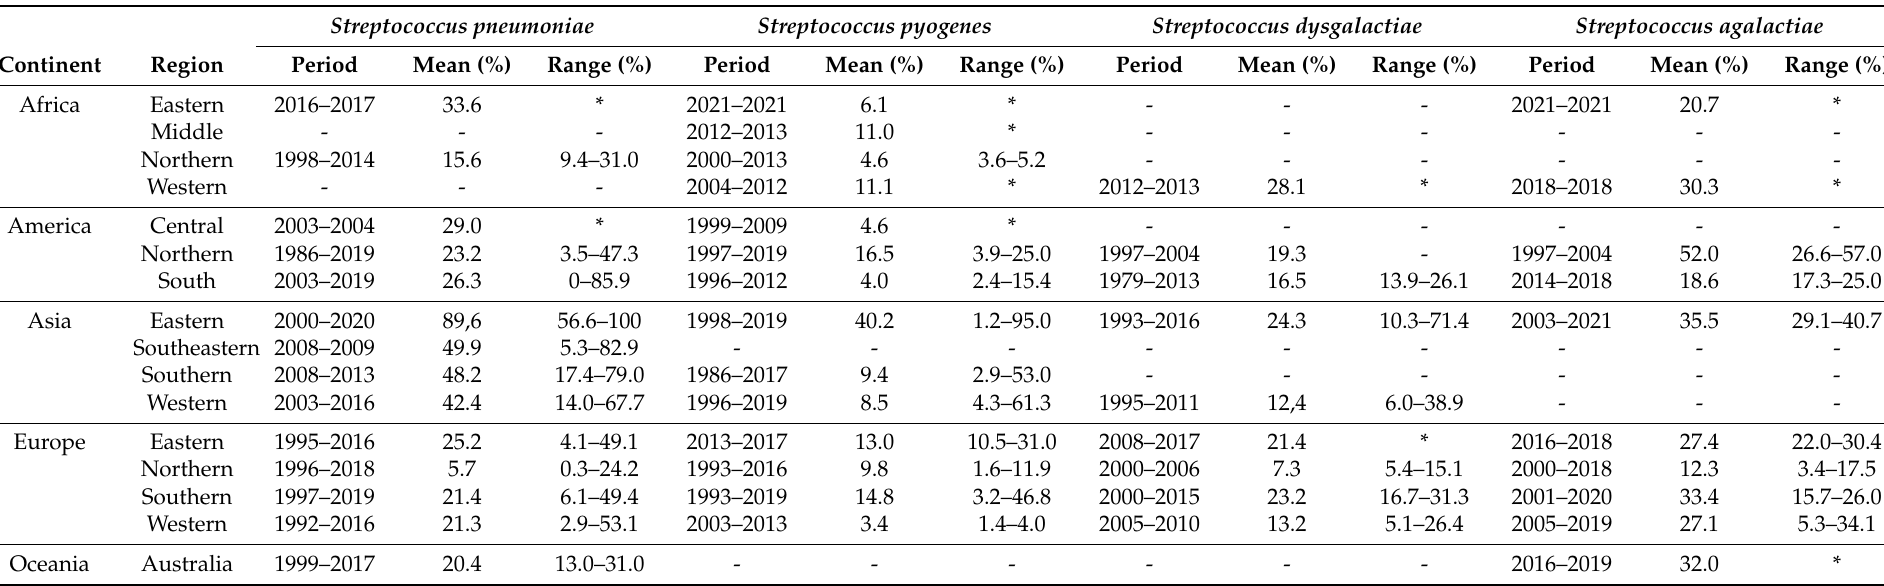
Table 1. Global distribution of macrolide resistance rates summarized by streptococcal species. This table synthesizes what is described in Supplementary Table S1, where the references can be